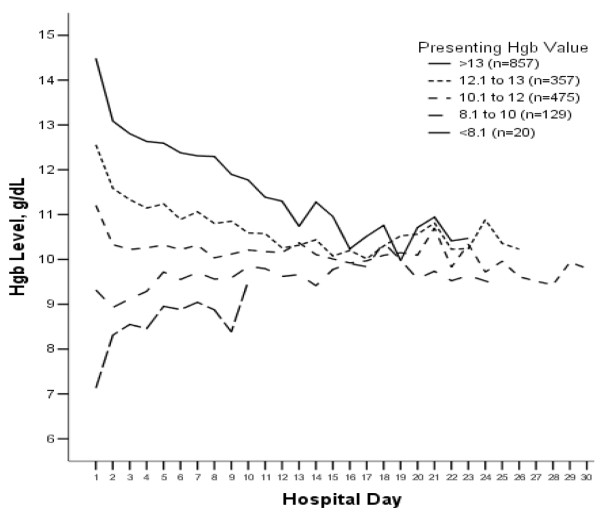
Course of hemoglobin by presenting hemoglobin category for patients remaining in hospital and having a hemoglobin obtained that day. Regardless of presenting hemoglobin category, mean hemoglobin concentrations regressed to a common value of around 10 g/dl. Censored for <5 observations/category/day to reduce effect of outliers. N = 55 subjects with no day 1 hemoglobin measurement excluded.